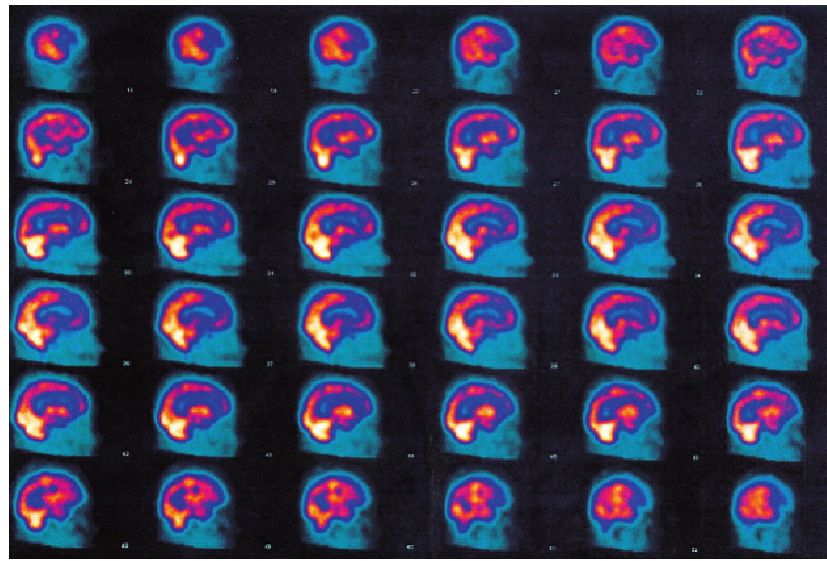
Figure 2. SPECT with Frontal lobes